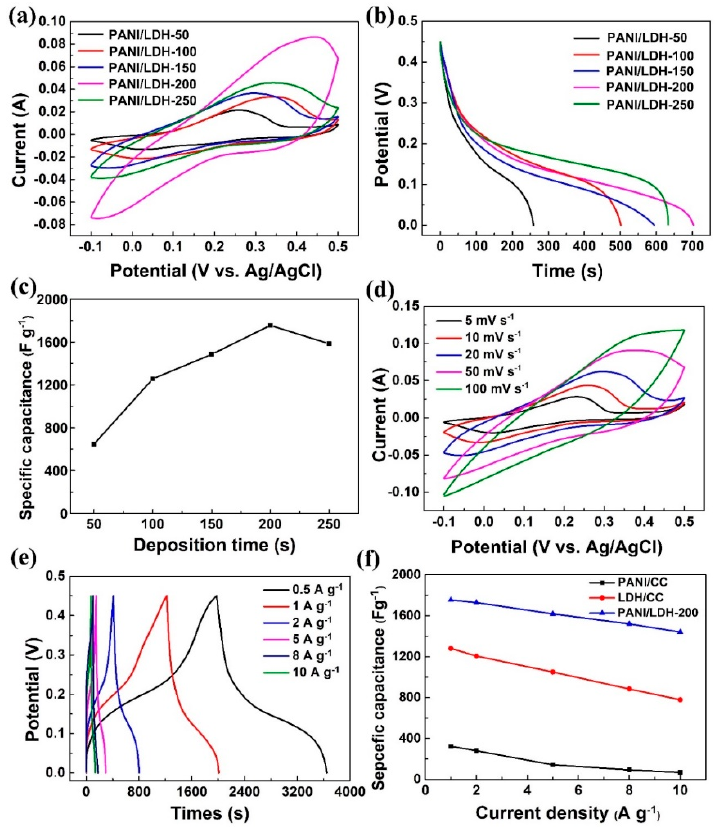
Figure 5. ( a ) CV curves of PANI/LDH-T (T = 50, 100, 150, 200, 250 s) at a scan rate of 20 mV s − 1 ; ( b ) GCD curves of the PANI/LDH-T at a current density of 1.0 A g − 1 ; ( c ) specific capacitance of different deposition times at a current density of 1.0 A g − 1 ; ( d ) CV curves of the PANI/LDH-200 at various scan rates; ( e ) GCD curves of the PANI/LDH-200 at different current densities; ( f ) the rate capability of the PANI/CC, LDH /CC and PANI/LDH-200.